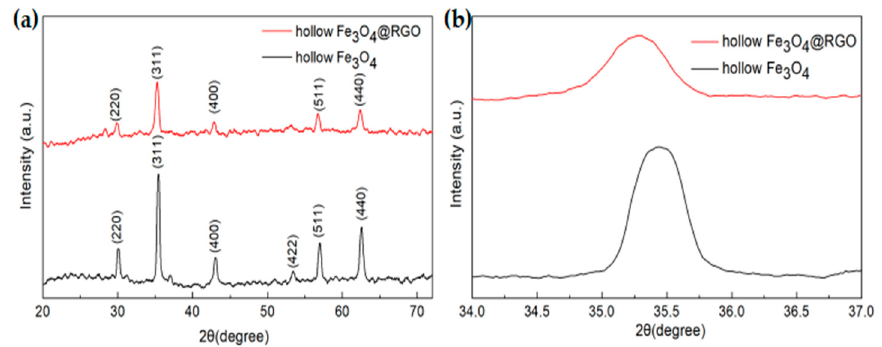
Figure 2. X-ray diffractometer (XRD) pattern of hollow Fe 3 O 4 @RGO ( a ) and the magnified image of the (311) peak ( b ).